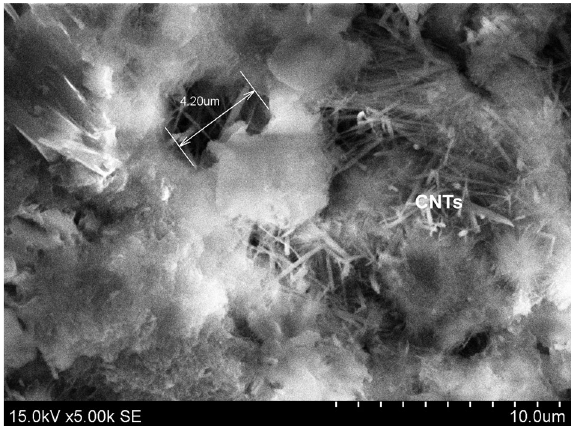
Figure 9. CNTs filling the micropores of the lightweight concrete structure.